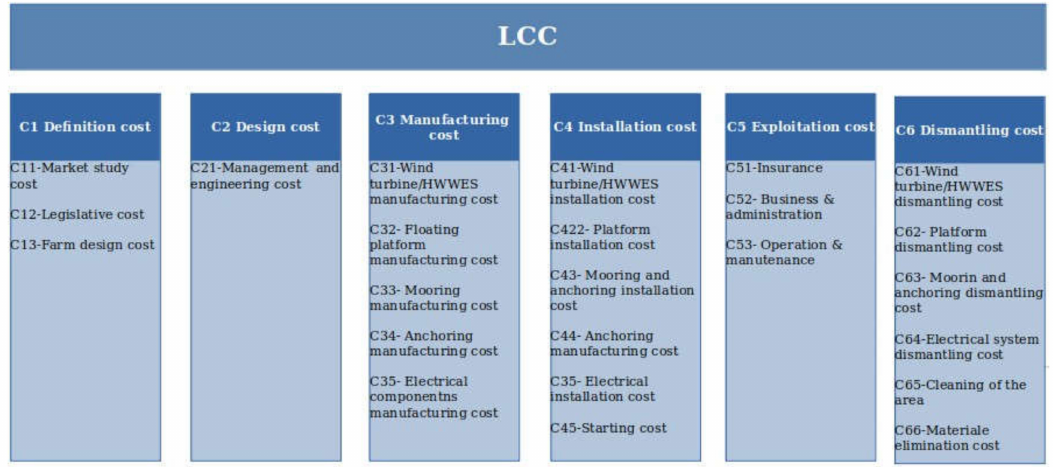
Figure 4. Main phases of the process for the life-cycle cost (LCC) analysis and related sub-costs.